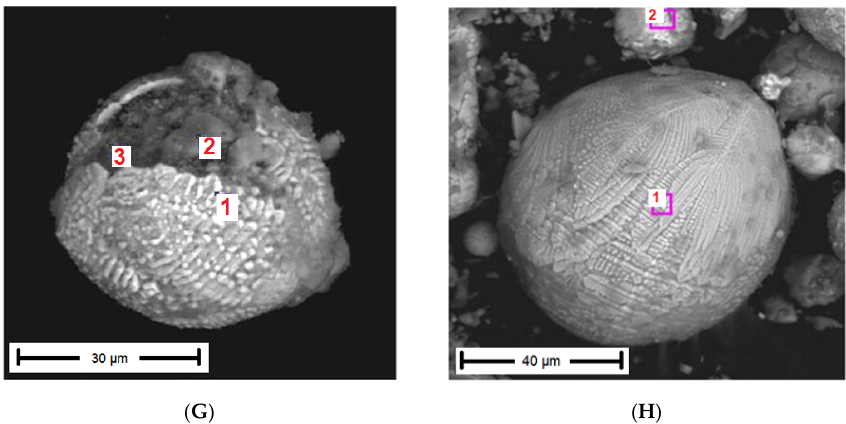
Figure 6. Electron microscopic images of magnetite particles identified by the magnetic phase of the upper soil horizons of Gubakha (layer 0–10 cm): ( A – D )—residential zone; ( E – H ) industrial zone of OAO “Gubakhinsky coke”.